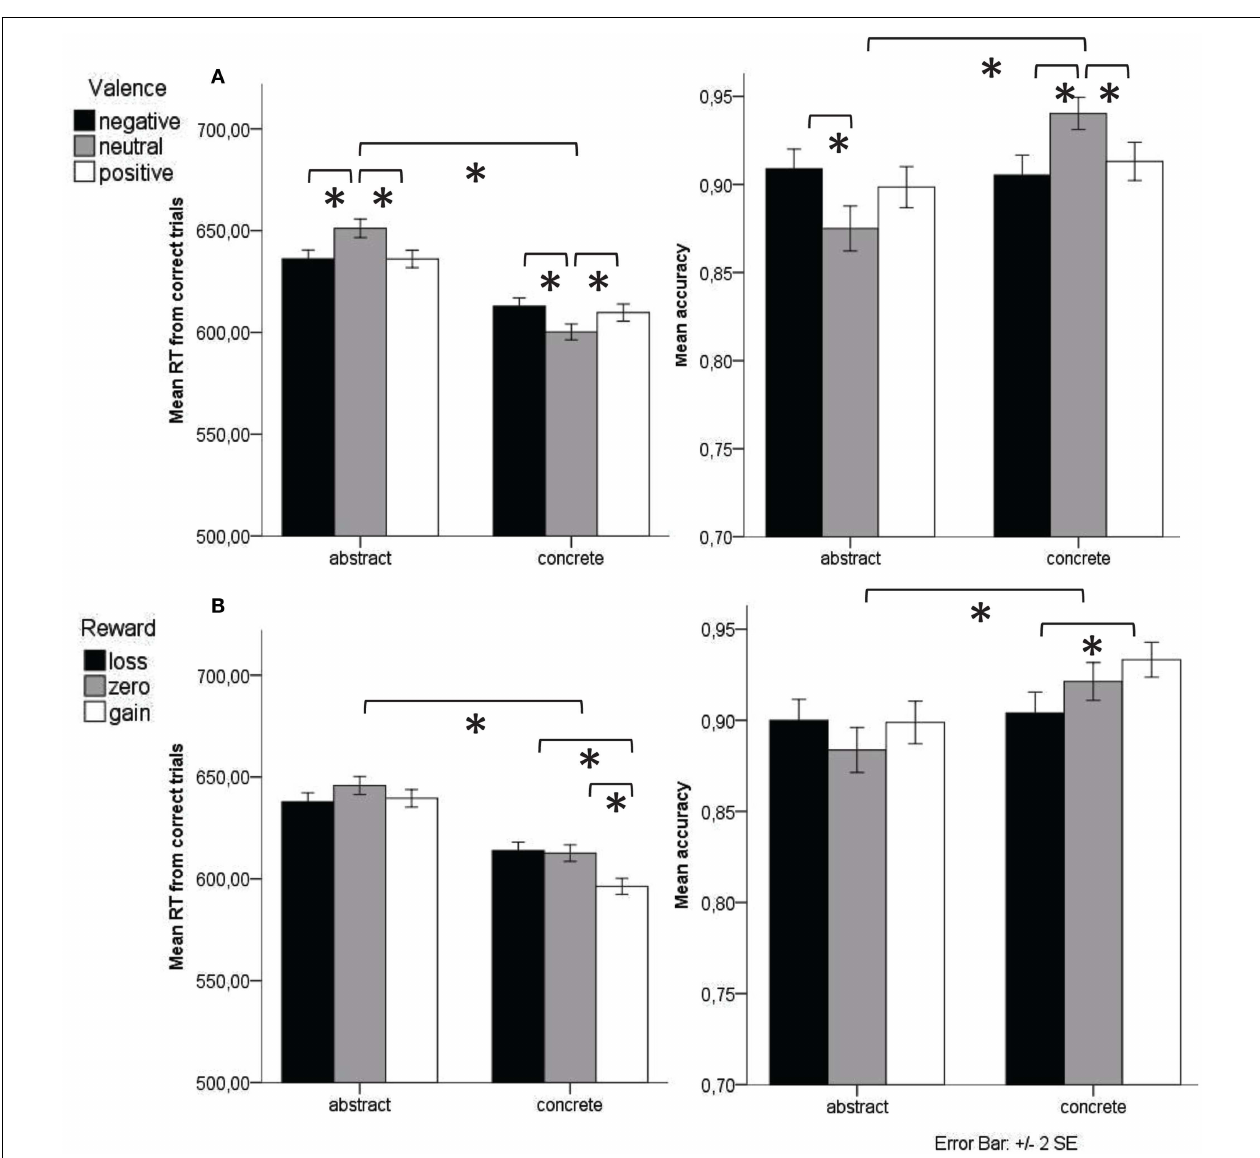
FIGURE 2 | Mean reaction time from correct trials and accuracy for valence (A) and reward expectancy (B) conditions in abstract and concrete words.